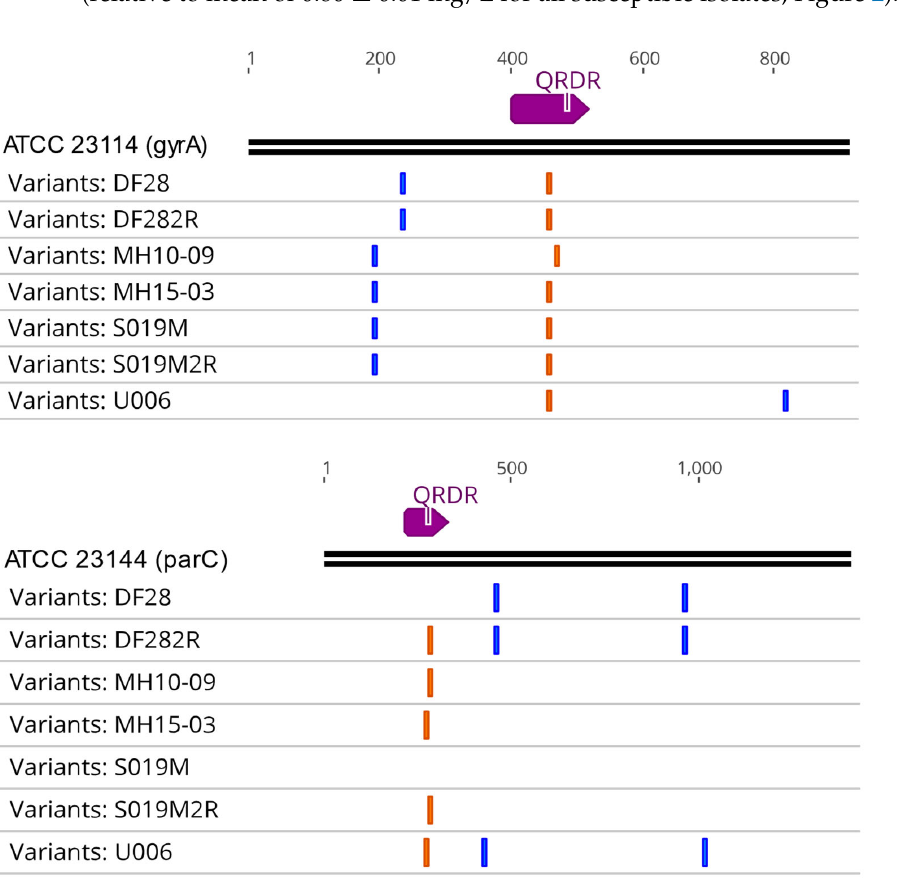
Figure 1. The single nucleotide polymorphisms (SNPs) of gyrA and parC genes found in the QRDR regions of all strains analyzed. Orange lines represent functional mutations, while blue lines represent synonymous mutations. No functional mutations were found in the QRDR regions of gyrB or parE .